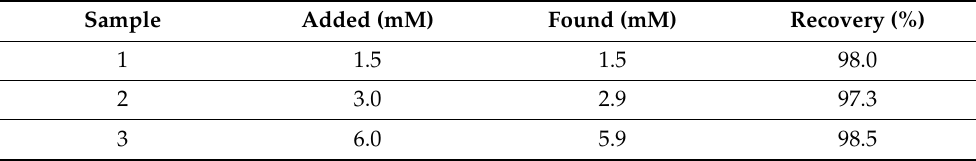
Table 2. L-C analysis data in acetylcysteine drug